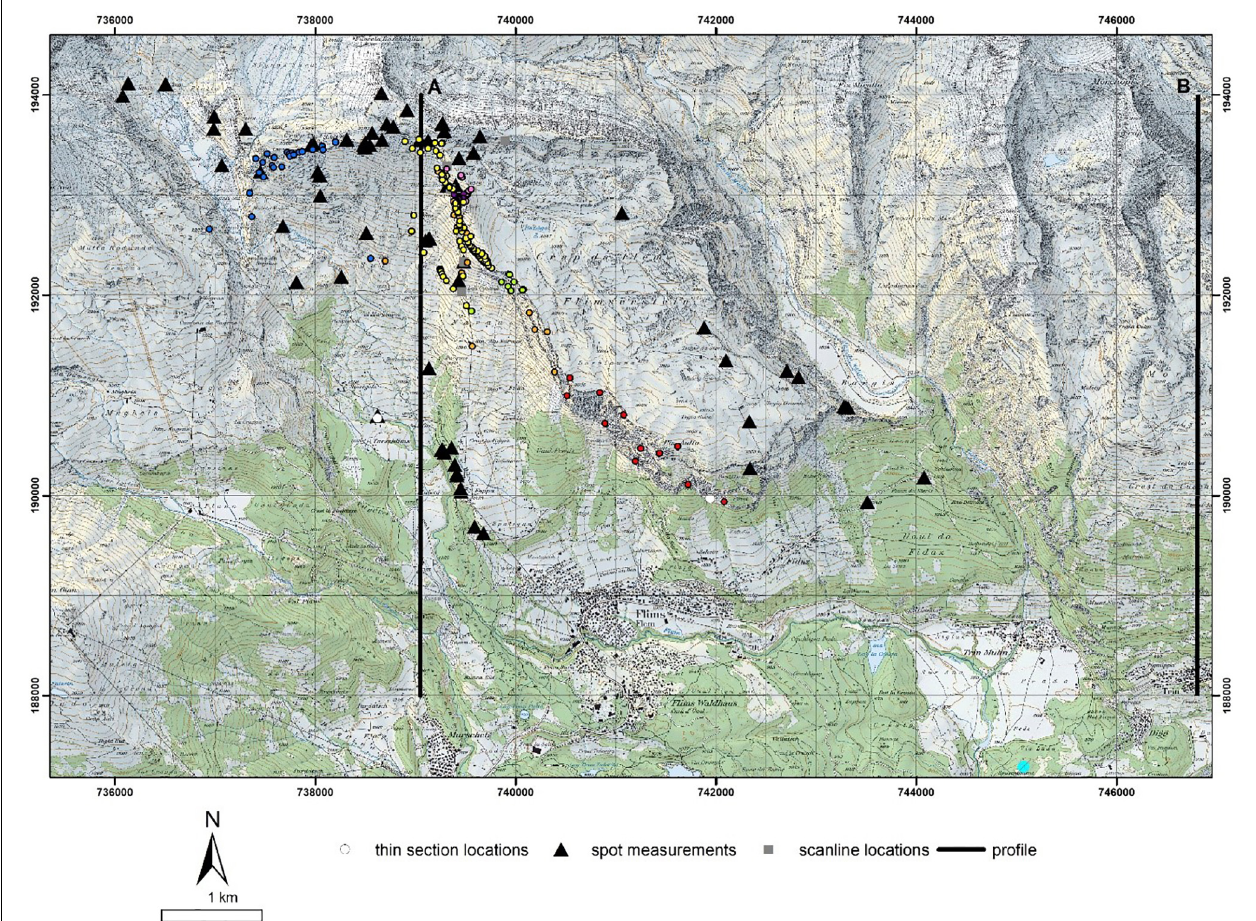
FIGURE 4 | Locations of spot measurements, scanlines, and profiles. Profile B was used to reconstruct the pre-failure surface along profile A, given similar slope geometries. Profile A was used as the modeling profile (see section below). Colored points are reference points used in the 10 photogrammetry models, represented as different colors for each model